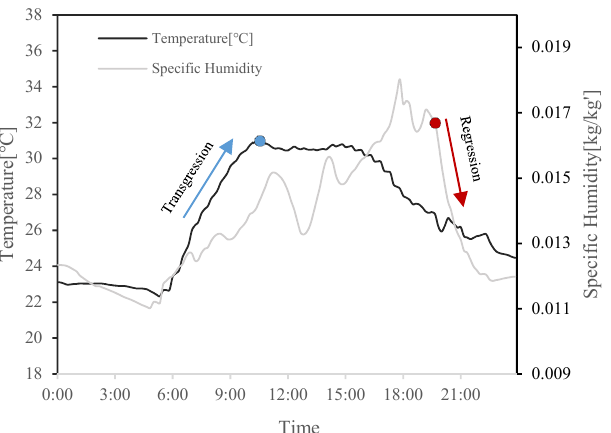
Figure 8. The diurnal temperature fluctuations and diurnal specific humidity fluctuations for 5 August 2016. The points pointed by the arrows show the time of arrival (blue points) and retreat of the sea breeze (red points).